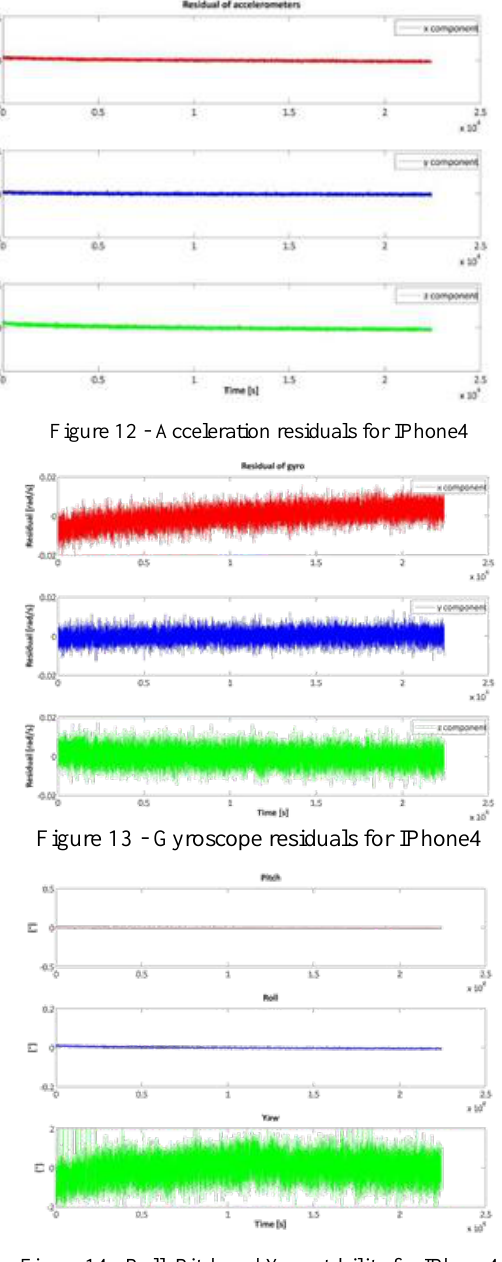
Figure 14 - Roll, Pitch and Yaw stability for